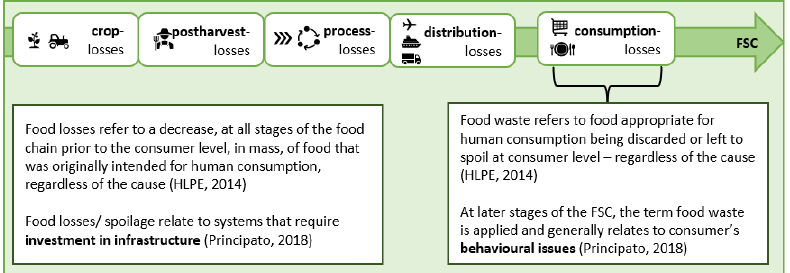
Figure 1. Food loss and waste definitions along the food supply chain (FSC) [6,23]. HLPE: High Level Panel of Experts on Food Security and Nutrition (HLPE) is the United Nations body for assessing the science related to world food security and nutrition.